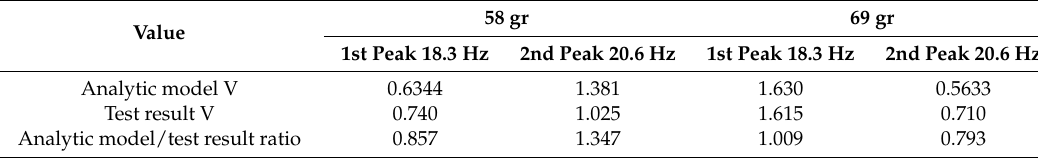
Table 7. Two bimorph system—model predictions vs. experimental results (voltage).